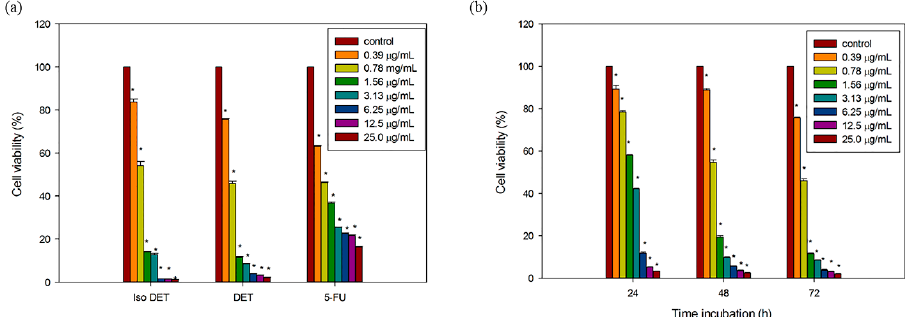
Figure 2. Effect of deoxyelephantopin and isodeoxyelephantopin on the cell viability of HCT116 cells. ( a ) The bar chart showed the percentage of cell viability after treatment with different concentrations of DET, isoDET and 5-fluorouracil ranging from 0.39–25.0 µg/mL on HCT116 cells for 72 h; ( b ) The bar chart showed the cytotoxicity of DET at different time incubation (24, 48 and 72 h) on HCT116 cells. The data expressed as mean ± S.E. of three independent experiments ( n = 9). Asterisks indicate significantly different value from control (* p < 0.05). The IC 50 values of DET and isoDET for HCT116 cells were 0.73 ± 0.01 µg/mL (2.12 µM) and 0.88 ± 0.02 µg/mL (2.56 µM), respectively (Table 3). DET was relatively less cytotoxic to the CCD841CoN normal cells (21.69 ± 0.92 µg/mL (60.02 µM)) when compared to HCT116 cells, revealing a 30 fold difference